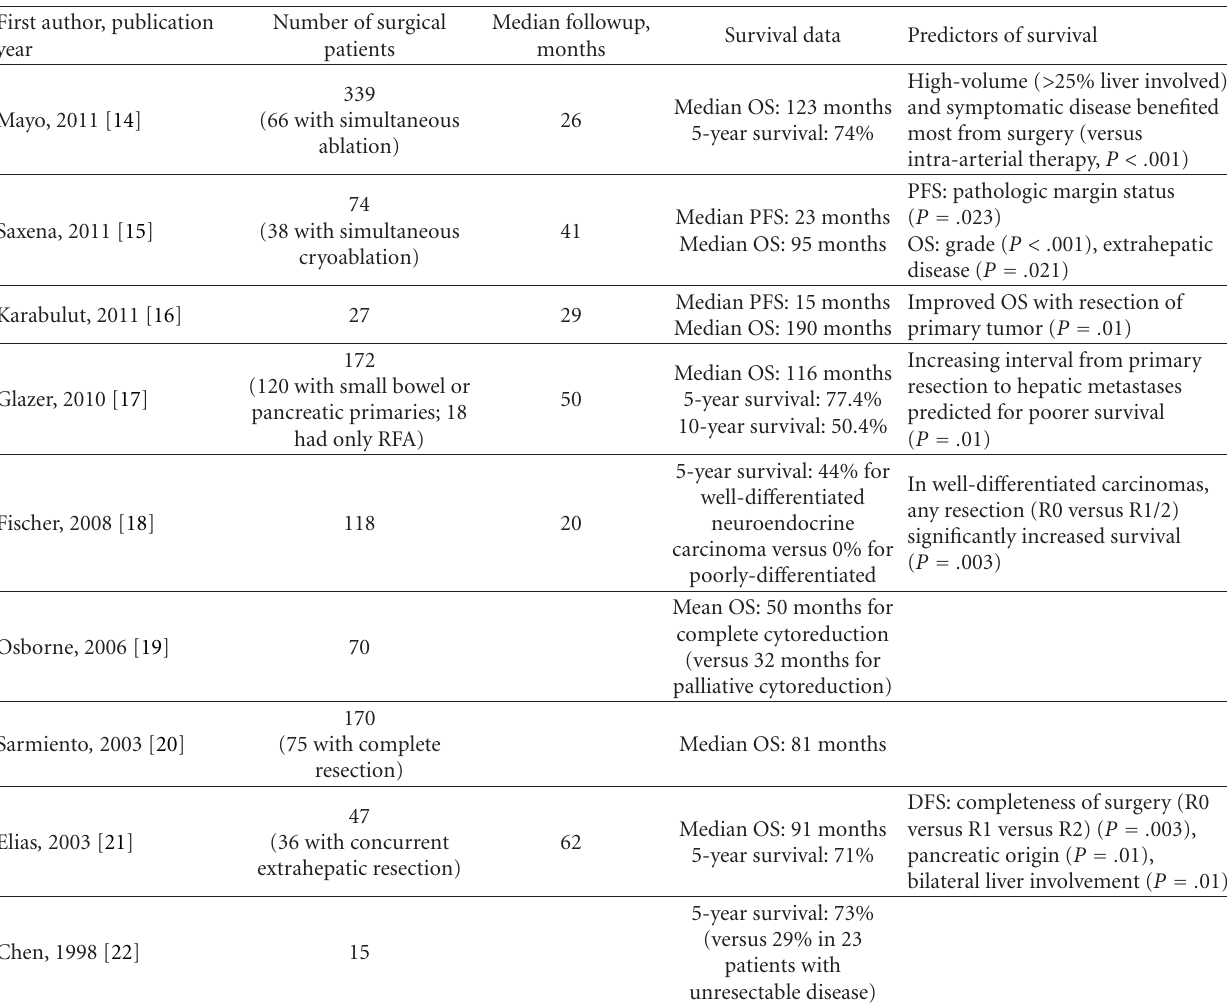
Table 1: Summary of outcome from resection of neuroendocrine liver